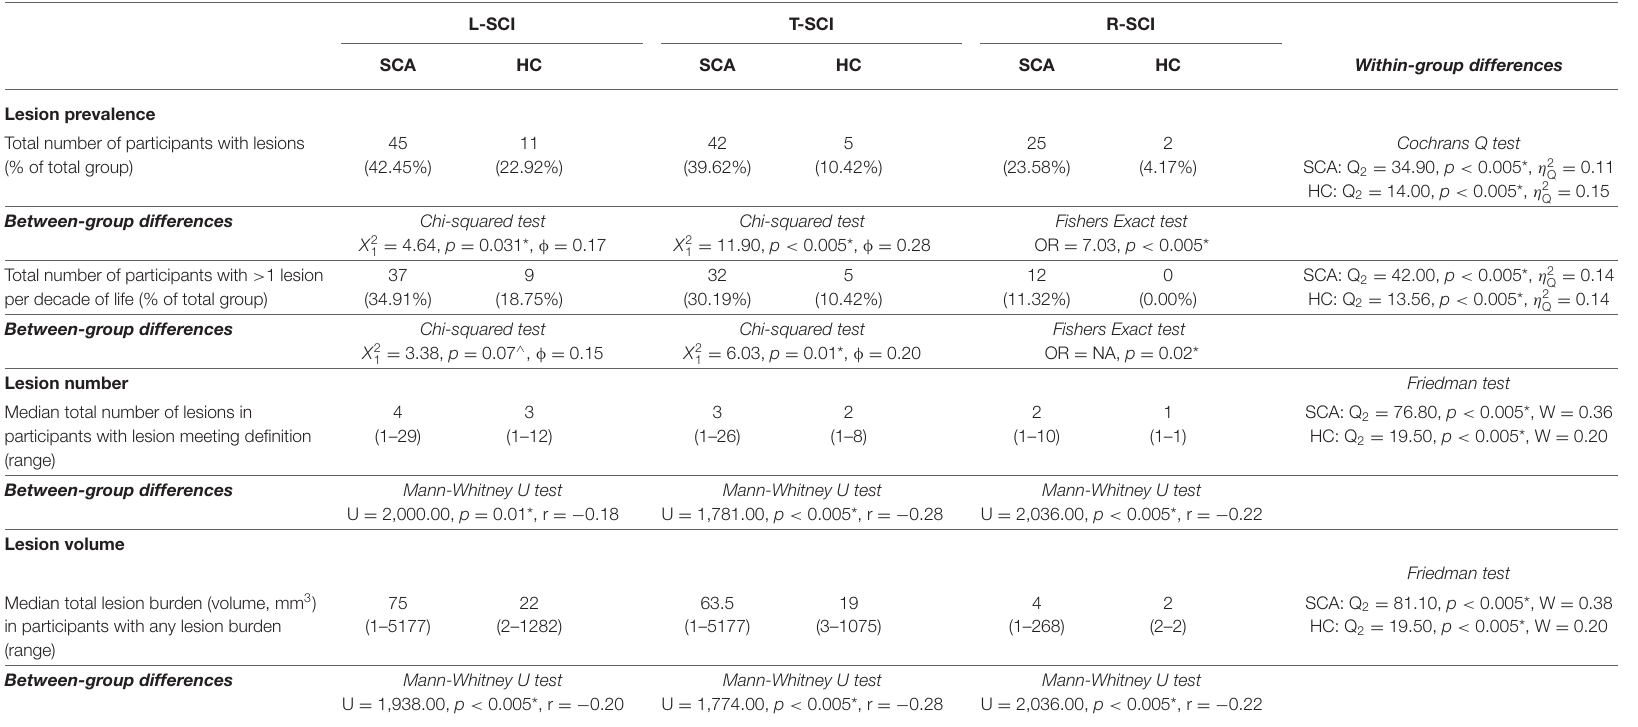
TABLE 3 | Global lesion